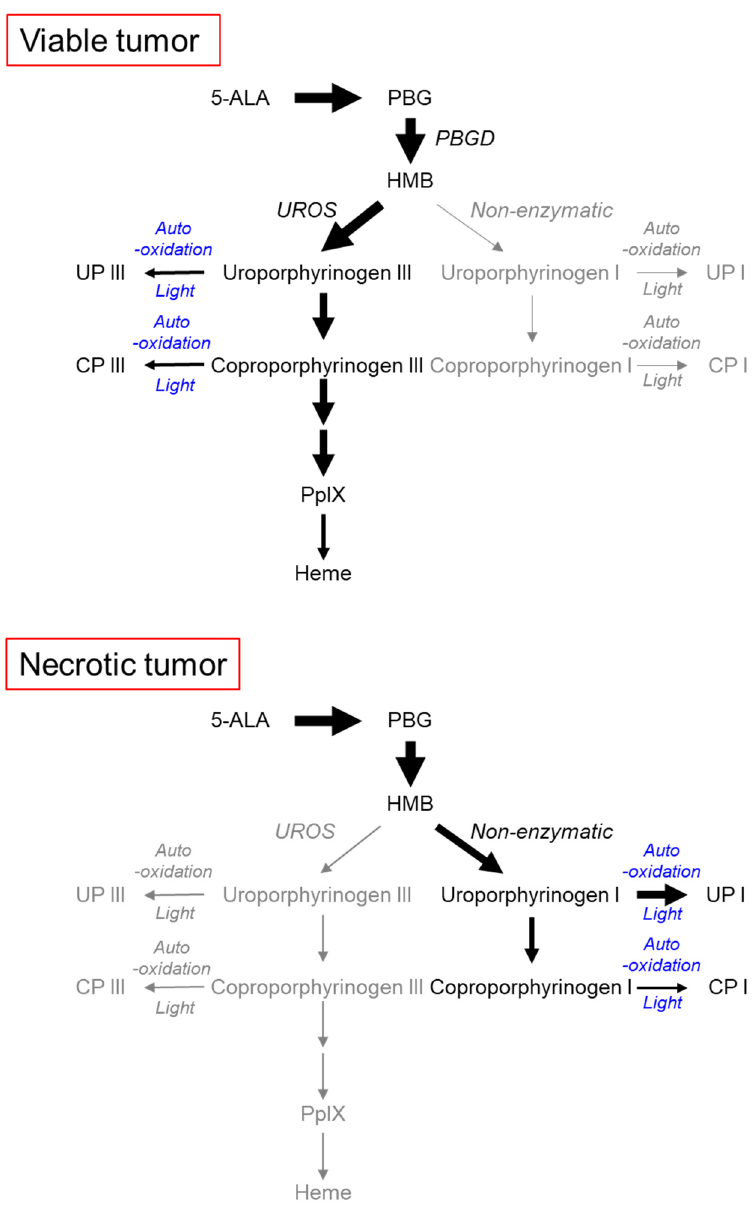
Figure 4. Model of the metabolic pathways of 5-ALA in viable and necrotic tumor tissues. Black and gray drawings in color represent mainstream and non-mainstream pathways, respectively. UPI, UPIII, CPI, and CPIII are generated from respective porphyrinogens by auto-oxidation and/or light-catalyzed reactions. PBG, porphobilinogen; PBGD, porphobilinogen deaminase; HMB, hydroxymethylbilane; UROS, uroporphyrinogen III synthase.